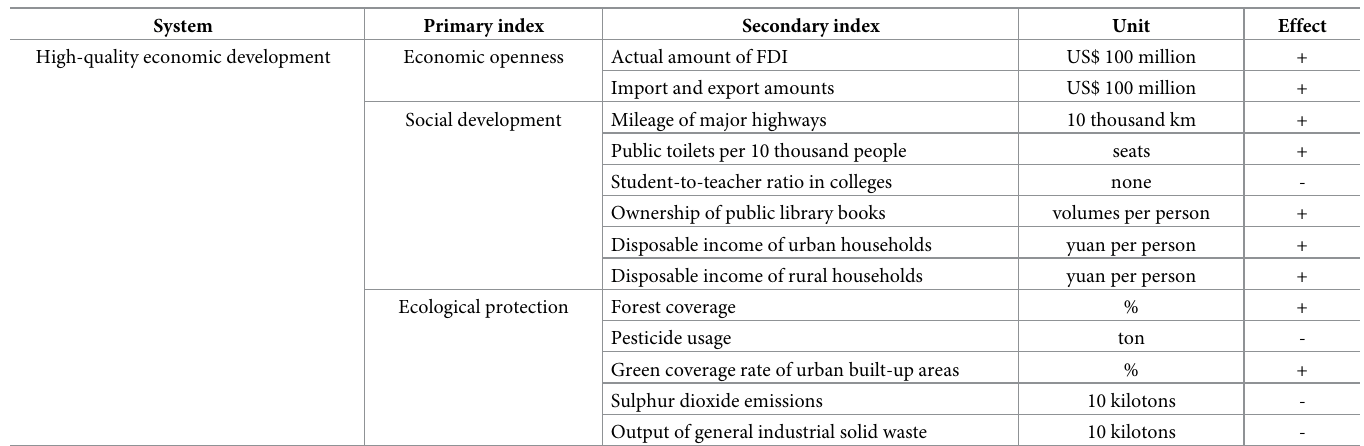
Table 1. Measurement system for high-quality economic development.